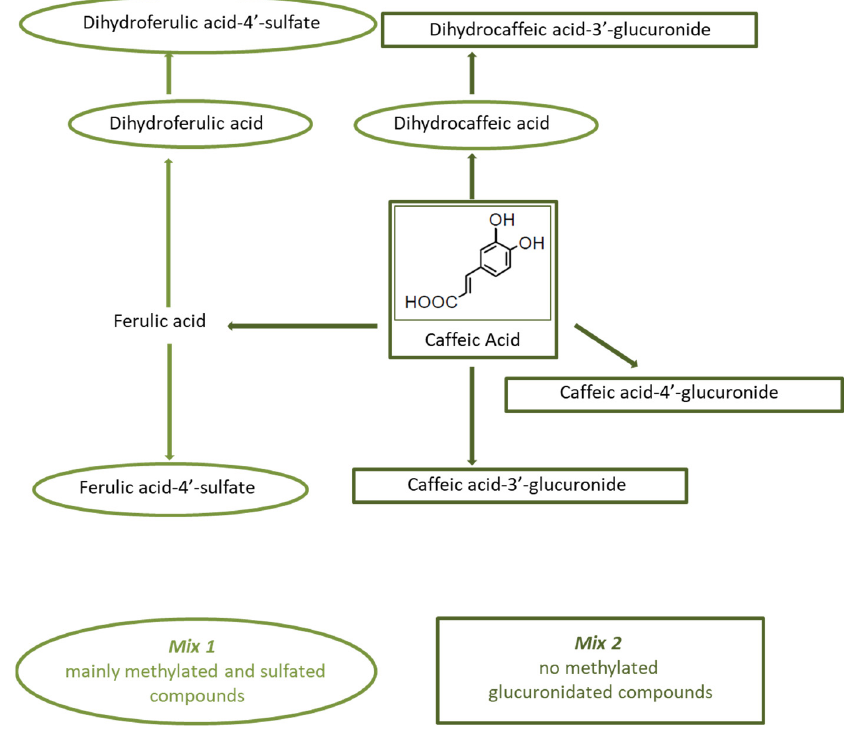
Figure 1. Schematic representation of the different coffee mixes.